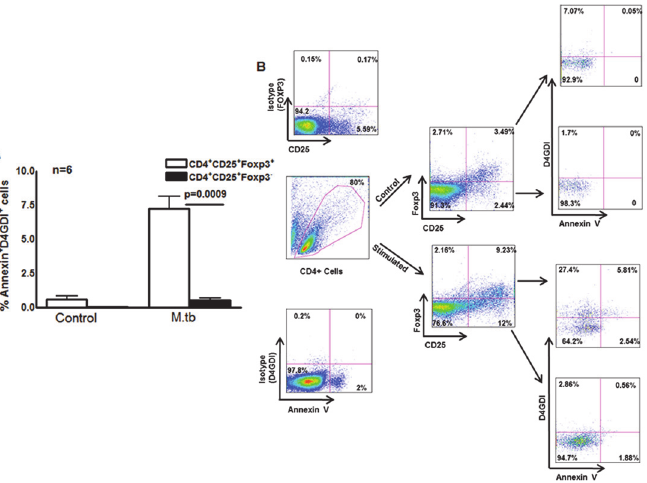
Figure 5. Apoptotic Foxp3 + cells are the source for D4GDI. (A) Expression of D4GDI by apoptotic Foxp3 + cells. CD4 + cells and autologous monocytes from 6 persons with LTBI were cultured with γ -irradiated H37Rv. After 4 days, CD4 + CD25 + Foxp3 + , CD4 + CD25 + Foxp3 - and CD4 + CD25 - Foxp3 - cells that expressed annexinV and/or D4GDI were identified by flow cytometry. Mean values, p values and SEs are shown. (B) A representative flow cytometry plot is